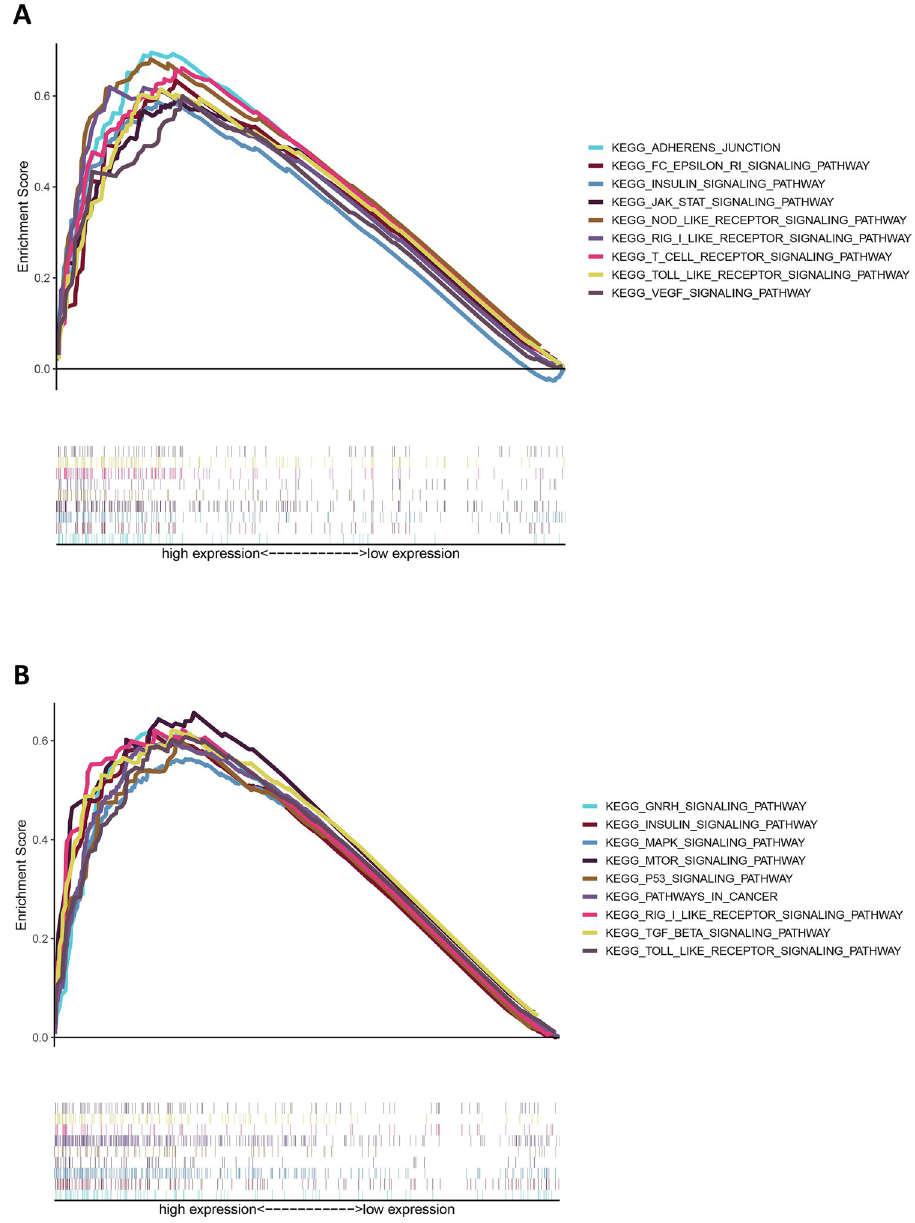
Fig 10. GSEA predicts SNX16 and PAPOLG related KEEG pathways. Pathways enriched in the SNX16 (A) and PAPOLG (B) high expression group, the enriched pathways are tumor and immune related. NOM < 0.01, FDR <